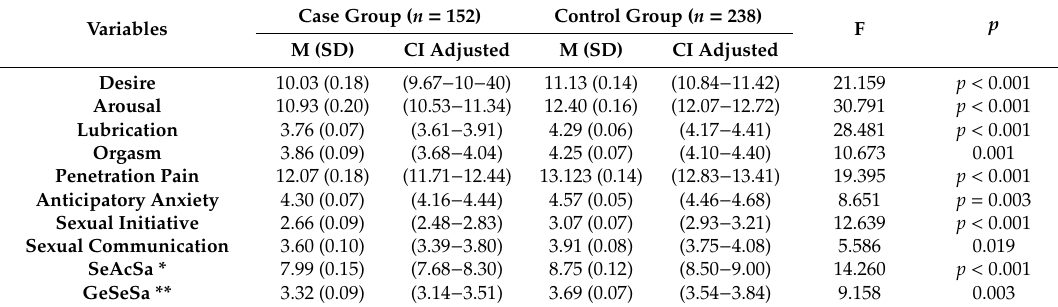
Table 4. Mean di ff erences (ANCOVA) in sexual dysfunction in case and control groups adjusted for age.